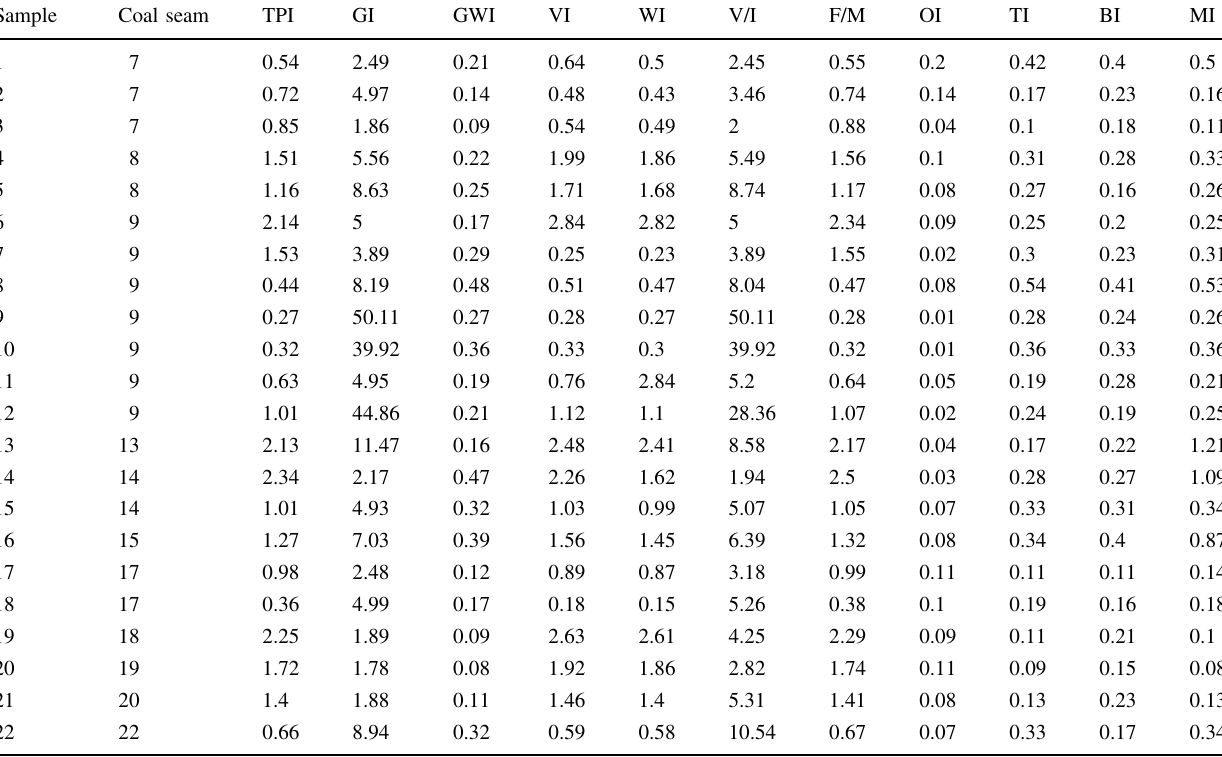
Table 2 The parameters of coal-forming swamp in Hanshuiquan district, Santanghu Coalfield, NW China Sample Coal seam